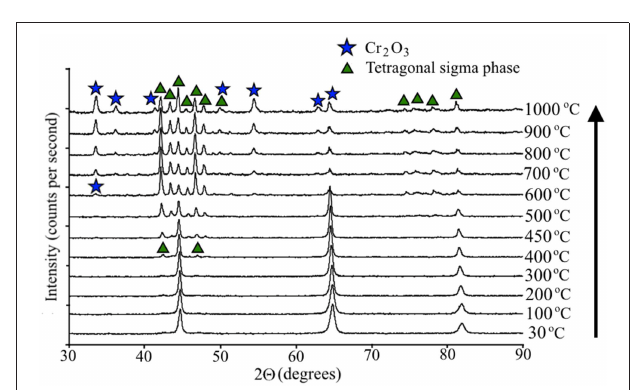
FIGURE 2 | Room temperature XRD patterns from (A) the SiFeVCr sample after annealing at 0.5 T m (981 ◦ C) and 0.65 T m (1276 ◦ C) for 48h, and from (B) the SiFeVCrMo sample after annealing at 0.5 T m (991 ◦ C) and 0.65 T m (1289 ◦ C) for 48h. The circles indicate peaks attributed to BCC Mo and triangles to tetragonal sigma phase.